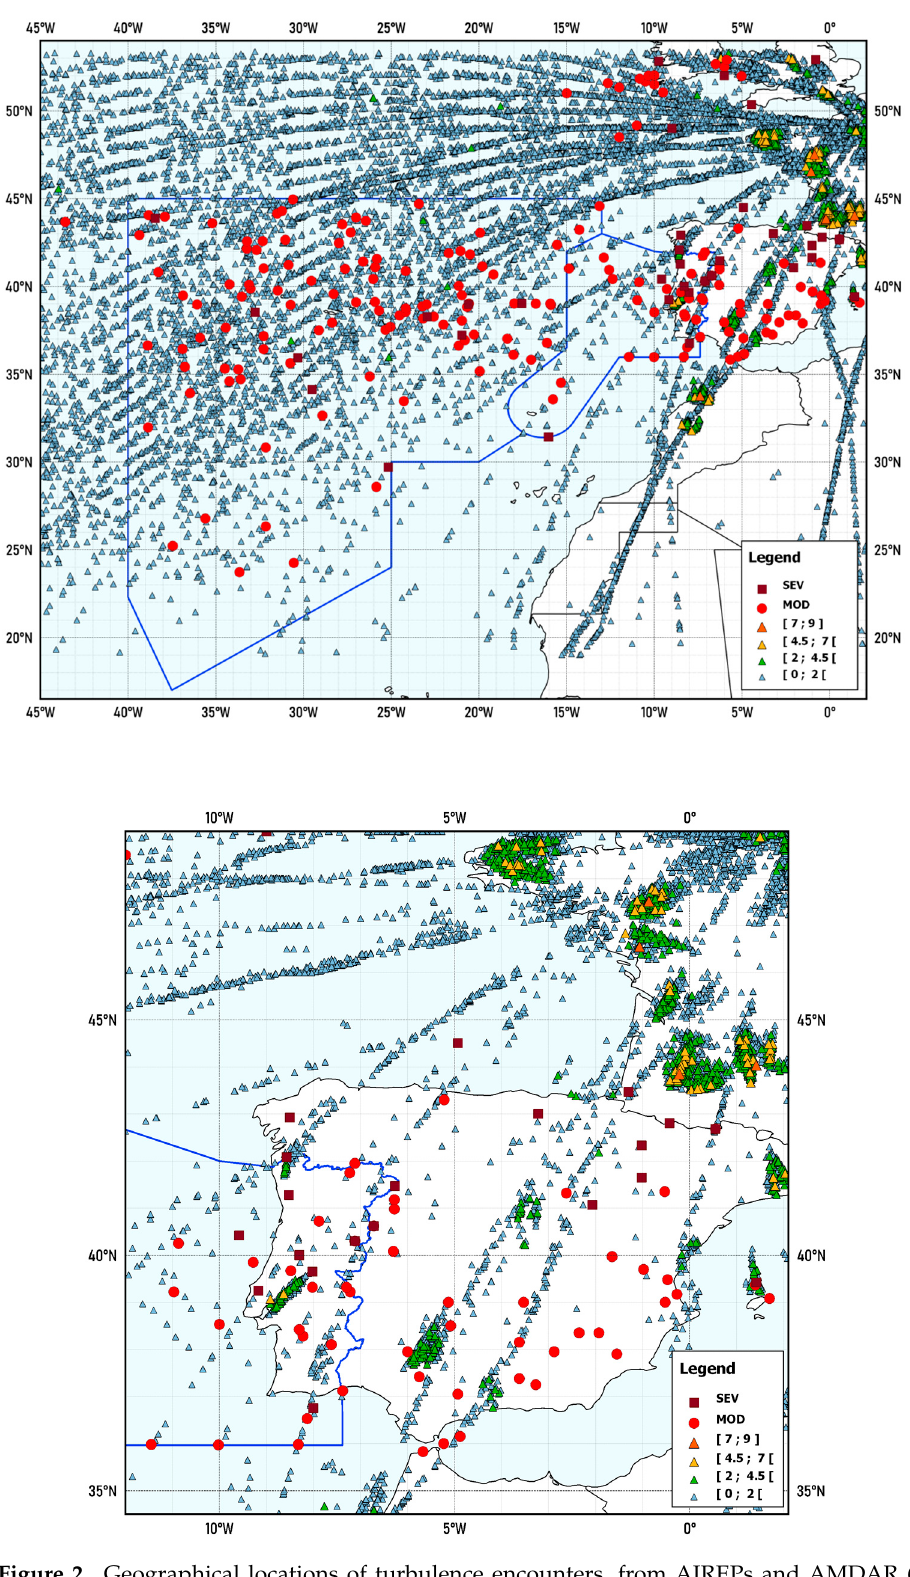
Figure 2. Geographical locations of turbulence encounters, from AIREPs and AMDAR (DEVG values), at altitudes above FL150 (>5 km) for the period from February 2020 to March 2021, excluding May and June. The square and circles represent AIREP data and the triangles represent the DEVG (m s − 1 ) values.